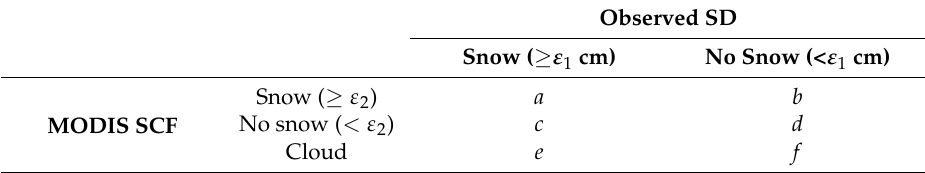
Table 1. Confusion matrix comparing MODIS SCF value with snow depth (SD)